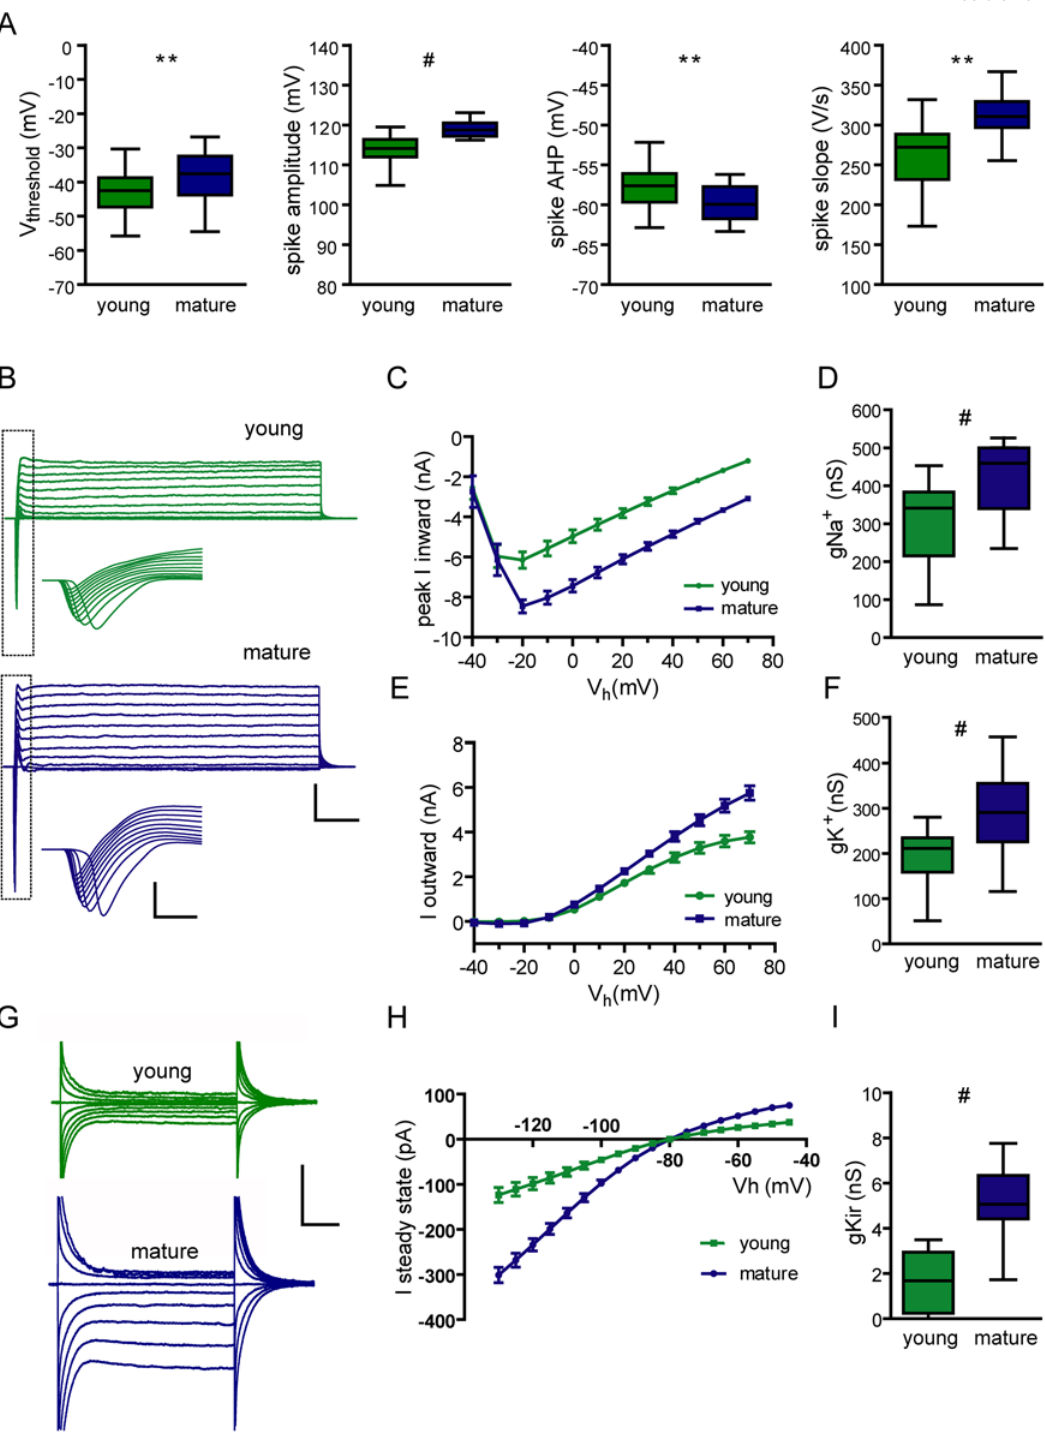
Figure 5. Active membrane properties of young neurons. (A) Characterization of action potentials recorded in young and mature neurons. Spiking threshold, N=38 (young) and 55 (mature); (*) denotes p =0.011. Spike amplitude, N=23 (both), ( # ) denotes p , 0.0001. Spike slope measured from the 10–90% rising phase, N=23 (both), ( # ) denotes p =0.0002. AHP measured as the absolute peak value, N=23 (both), (**) denotes p =0.0024. Box plots depict the median (line), 25–75% percentile (box limits) and the maximum and minimum values (whiskers). Statistical analysis was done using a two-tailed t -test. (B) Typical examples of inward (downward deflections) and outward (upward deflections) currents recorded in response to depolarizing voltage steps ( 2 40 to 70 mV, step 10 mV, 200 ms) in a 25 dpi (green) and a mature DGC (blue). Scale bars: 5 nA, 50 ms. Insets depict expanded views of the squared areas (scales: 5 nA, 1 ms). (C) I–V curve for voltage-gated Na + currents, displaying different amplitudes for young and mature cells (ANOVA, p , 0.0001, N=26 young and 29 mature DGCs). (D) Na + conductance measured at V h = 2 20 mV; ( # ) denote p , 0.0001. (E) I–V curve for voltage-gated K + currents measured at steady state showing significant differences (ANOVA, p , 0.0001). (F) K + conductance measured at V h =70 mV; ( # ) correspond to p , 0.0001. (G) Inward rectifying currents evoked by current steps from 2 40 to 2 130 mV (step 5 mV, 100 ms) recorded from a 23 dpi and a mature DGC. Scale bars: 200 pA, 20 ms. (H) Average I–V plots displaying inward rectifier K + currents are significantly larger in mature neurons ( p , 0.0001), ANOVA with N=19 (young) and 17 (mature). (I) K + inward-rectifier conductance; ( # ) denotes p , 0.0001. doi:10.1371/journal.pone.0005320.g005 PLoS ONE |